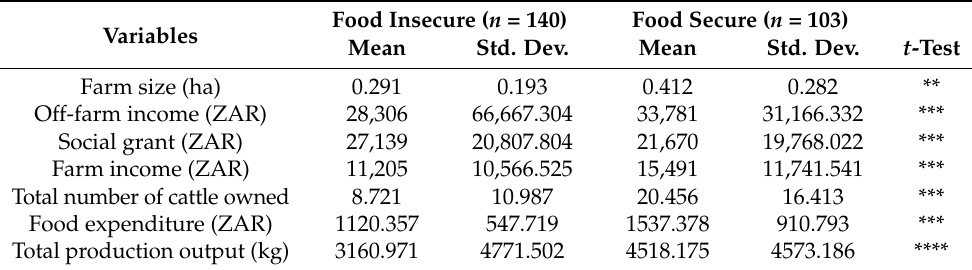
Table 3. T -test results for household food-security